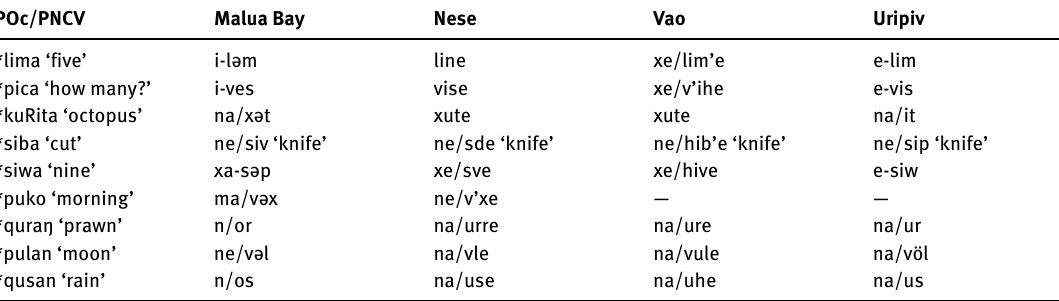
Table 6: Final vowels in Nese and Vao and their neighbours/relatives